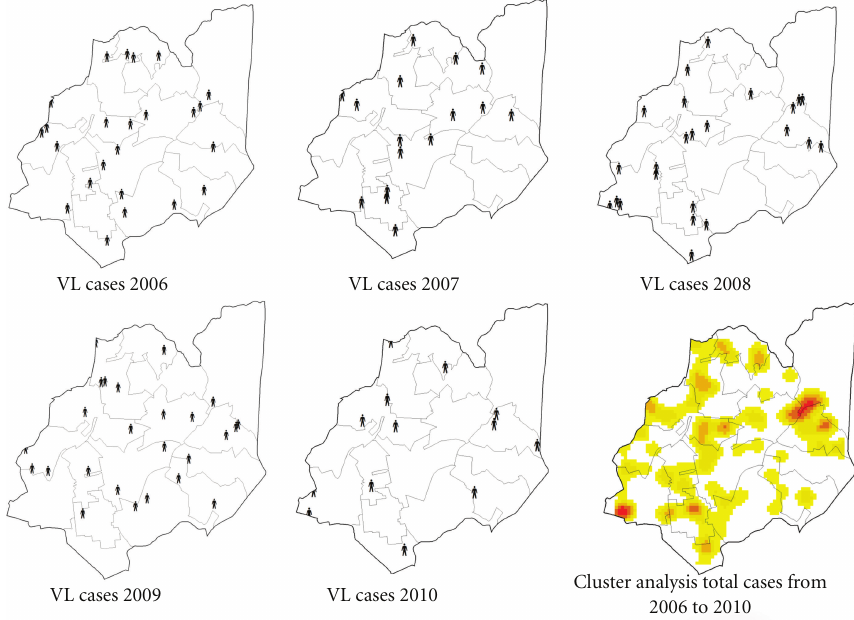
Figure 5: Human cases of Visceral Leishmaniases SD Venda Nova from 2006 to 2010, cluster analysis considering all cases from 2006 to